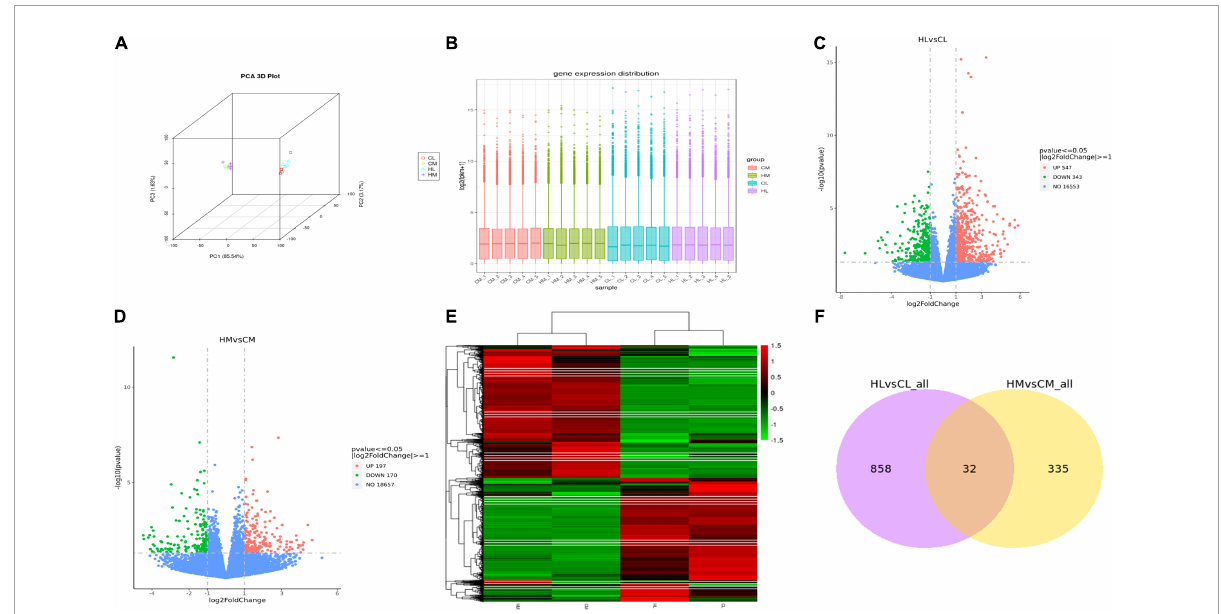
FIGURE2 Transcriptomic analysis of liver and breast muscle tissues in the high linseed oil and control groups. (A) PCA 3D Plot of samples. (B) Box plot of sample gene expression distribution. (C) Volcano plots of the DEGs between HL and CL. (D) Volcano plots of the DEGs between HM and CM. (E) Cluster heatmap of the DEGs, red: upregulated genes; green: downregulated genes. (F) Venn diagram indicated unique and shared DEGs between HL vs. CL and HM vs. CM.